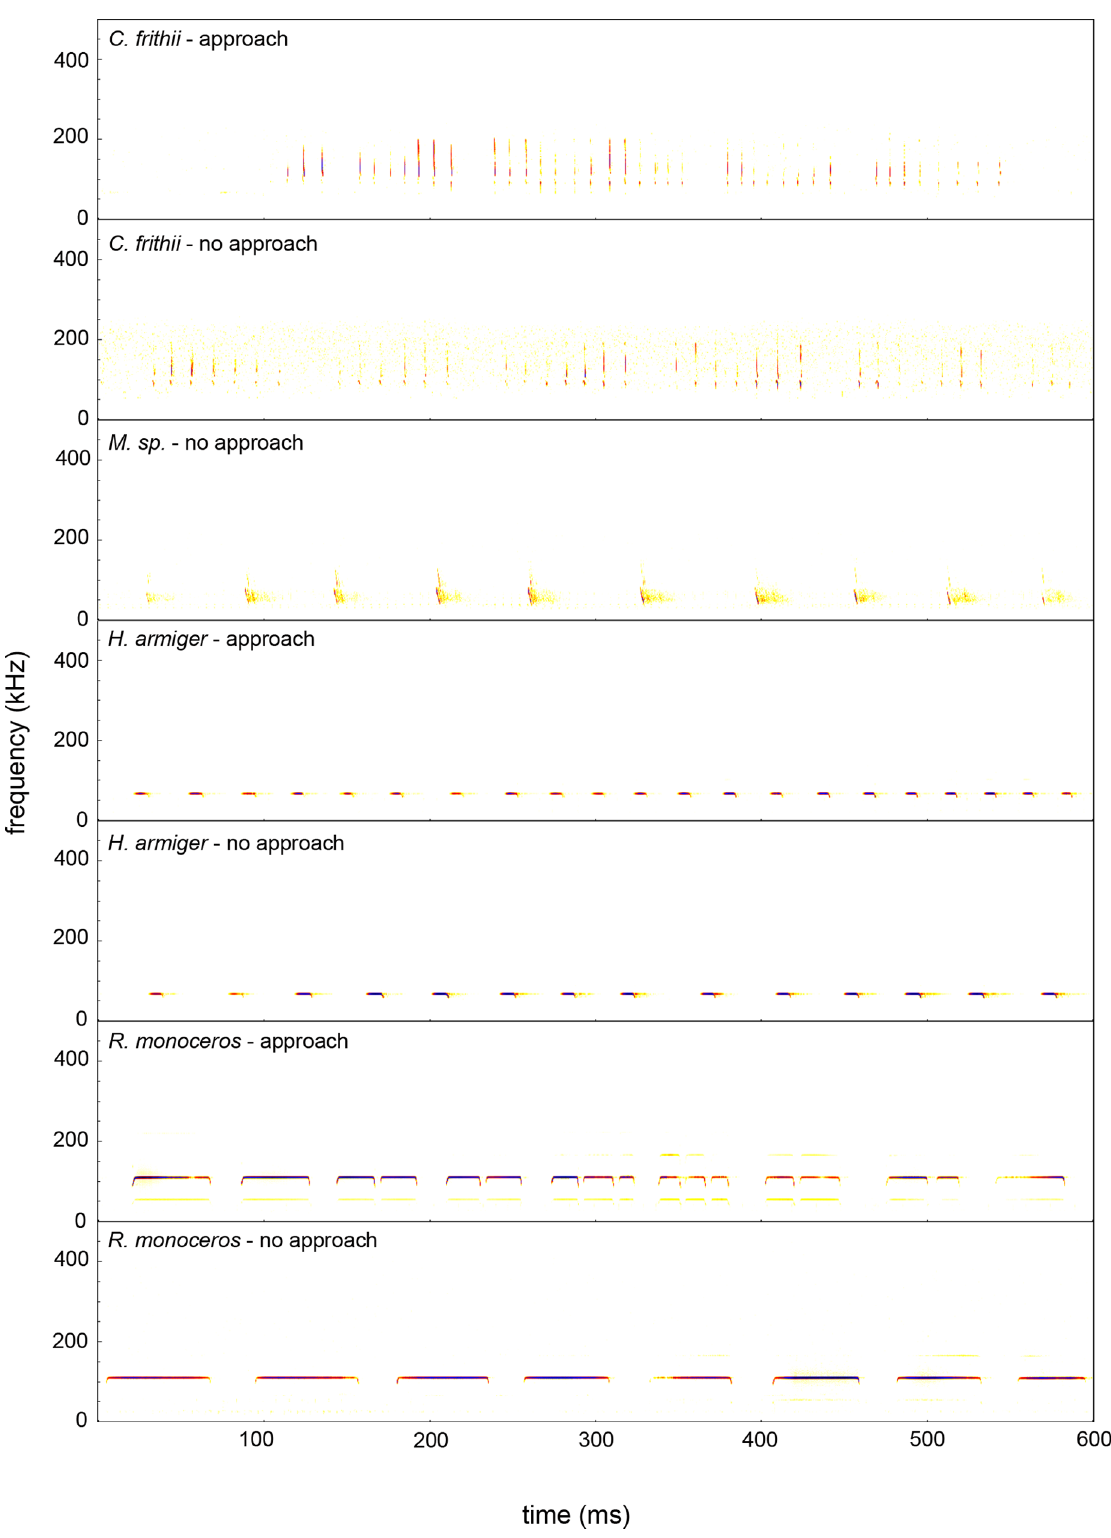
Figure 2. Spectrograms illustrating echolocation call sequences of Coelopsfrithii , Myotis sp., Hipposiderosarmiger , and Rhinolophus monoceros during passes that both approached and did not approach a fluttering target. Short title : Echolocation call sequences of Coelops frithii , Myotis sp., Hipposideros armiger , and Rhinolophus monoceros .